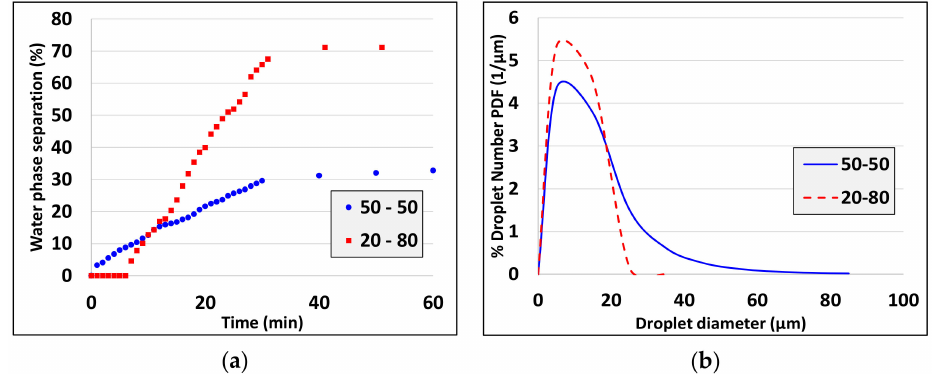
Figure 14. E ff ect of oil to water ratio ϕ on ( a ) water phase separation and ( b ) droplet size distribution of emulsions (C SDS = 1 CMC, t n = 2min, and f = 10Hz; Piston 2, ϕ = 0.5: d av = 14.4 µ m, ϕ =